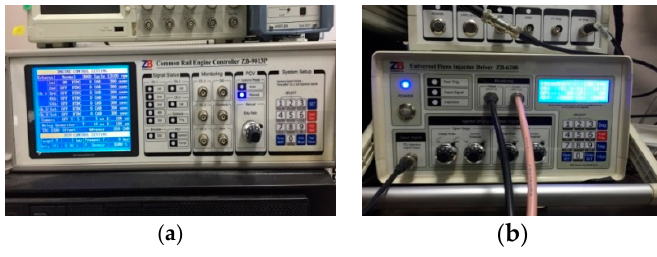
Figure 2. Fuel injection control system; ( a ) Common-rail controller, ( b ) Injector driver.